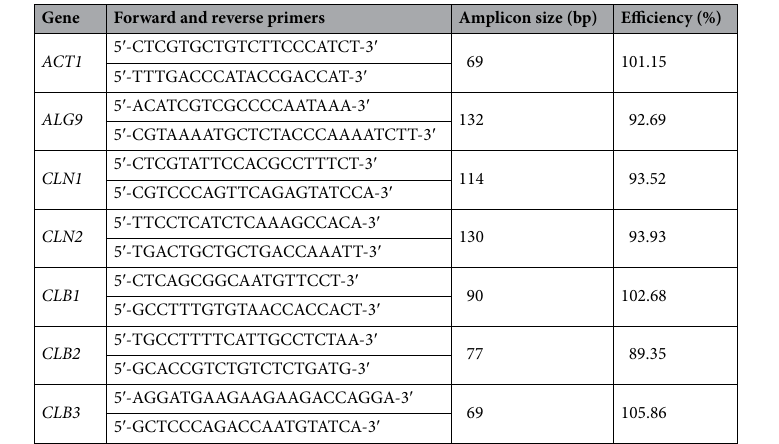
Table 2. Primer sequences, amplicon sizes, and efficiencies for qPCR